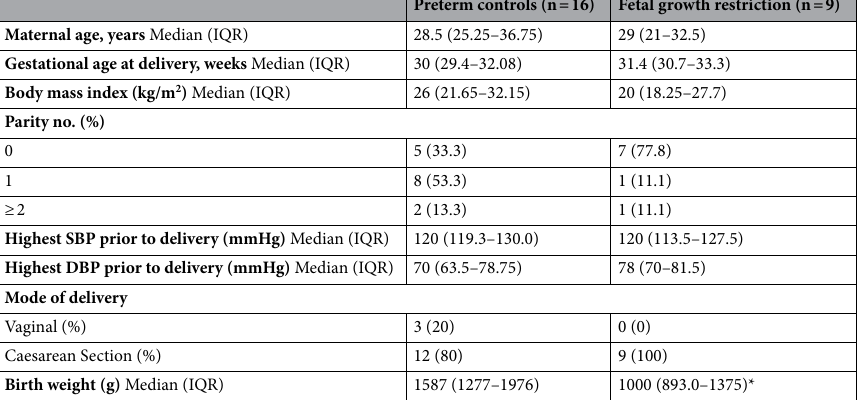
Preterm controls (n = 16) Fetal growth restriction (n = 9)